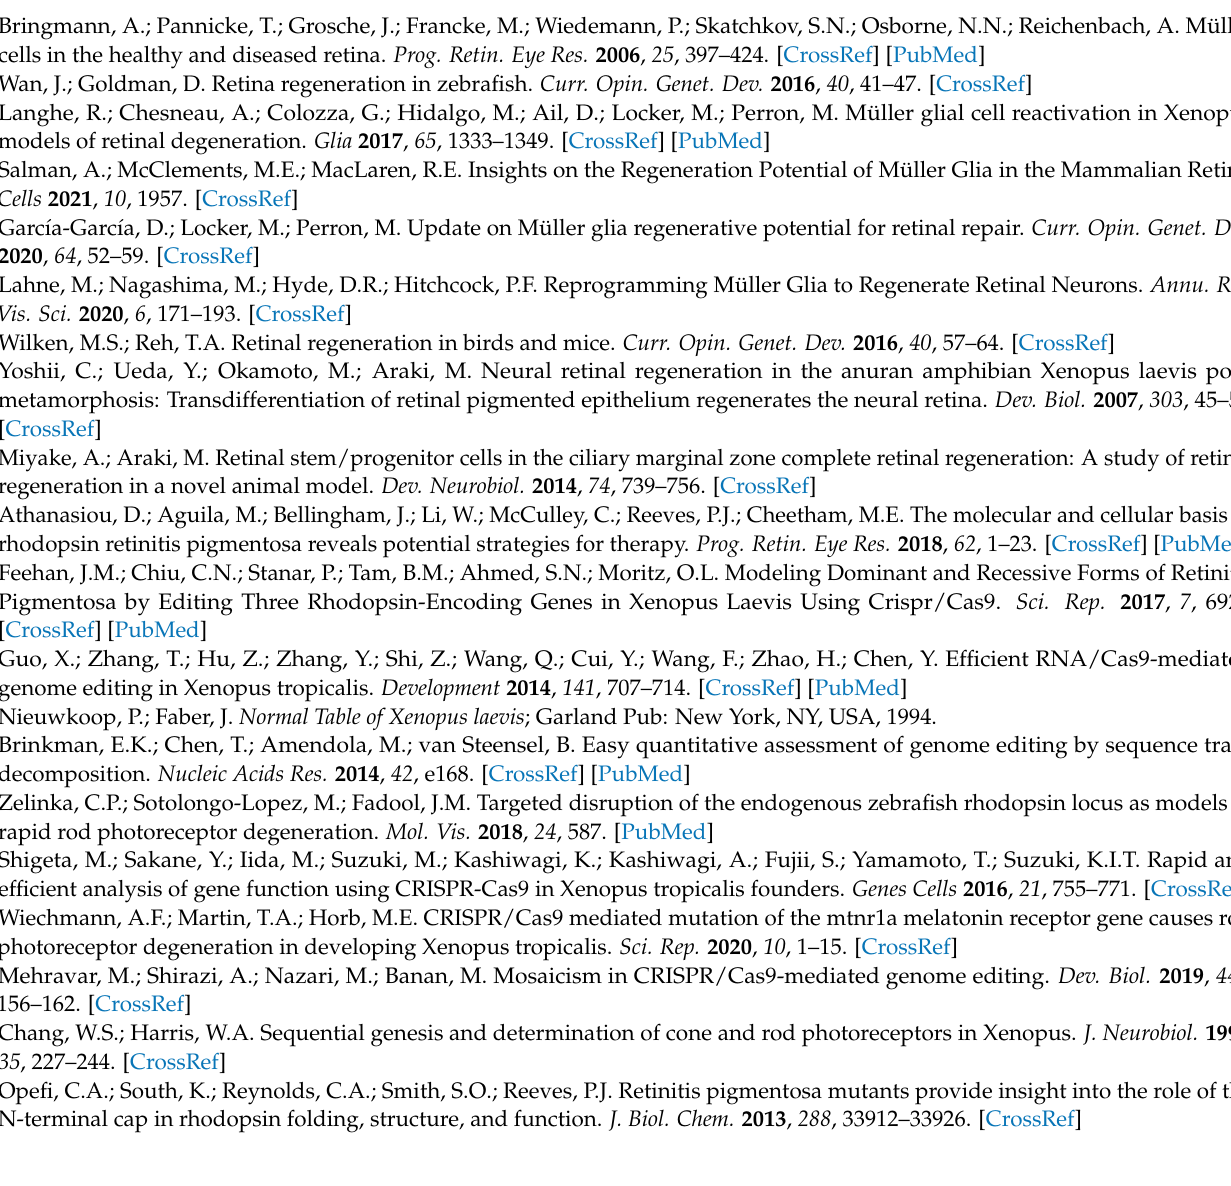
crispants, Figure S2: Analysis of proliferative cells in X. laevis rho crispants, Table S1: Primers, Table S2: List of